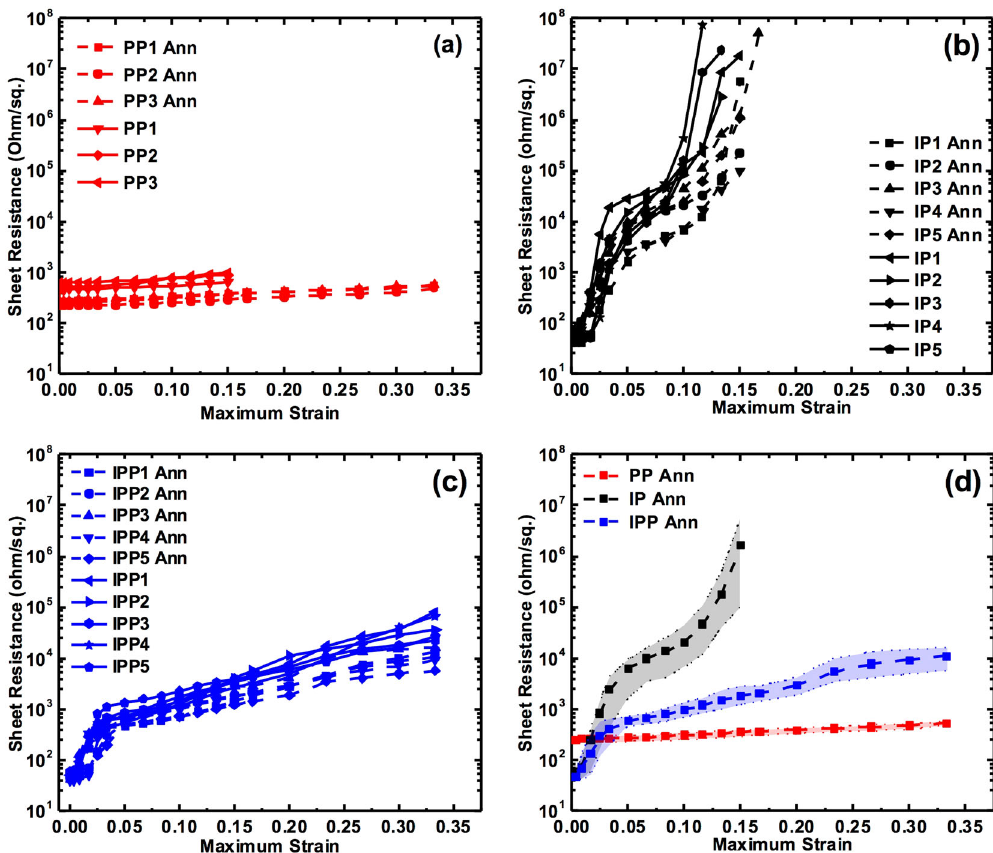
Fig. 4 Applied strain versus two-probe in-situ sheet resistance (monotonic tensile testing), for the following sets of fi lms: ( a ) PP, ( b ) IP, and ( c ) IPP, for both as-deposited and annealed samples. Comparison of the envelopes for PP, IP, and IPP annealed samples to ease the comparison ( d